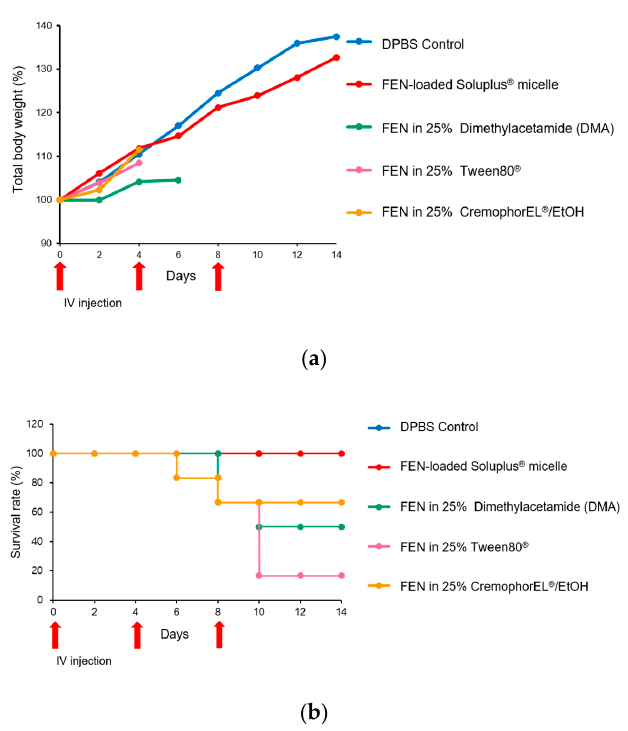
Figure 9. Relative rat body weight changes and survival rates after three intravenous injections of Dulbecco’s phosphate-buffered saline (DPBS) control, fenbendazole (FEN) dissolved in 25% Cremophor EL ® /EtOH, FEN dissolved in 25% dimethylacetamide (DMA), FEN dissolved in 25% Tween 80 ® , or FEN-loaded Soluplus ® micelles on days 0, 4, and 8 (All doses are equal to 2 mgmL · kg − 1 ). ( a ) Relative daily body weight change. Missing data points indicate death of an animal. ( b ) Kaplan–Meier plot illustrating survival